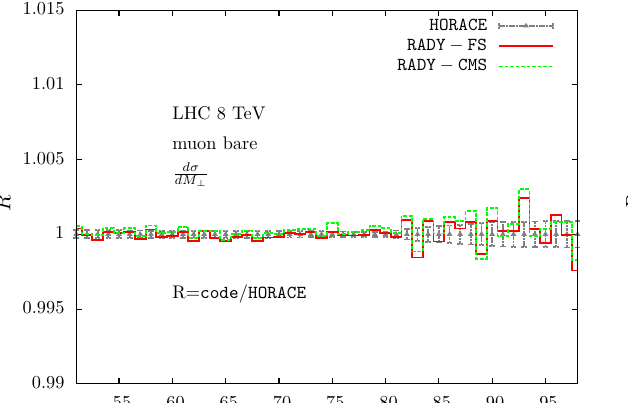
in pp → W + → μ + ν μ + X at the 8 TeV LHC with ATLAS/CMS cuts in the bare setup. The definitions of the FS, CMS and PS schemes can be found in Ref.